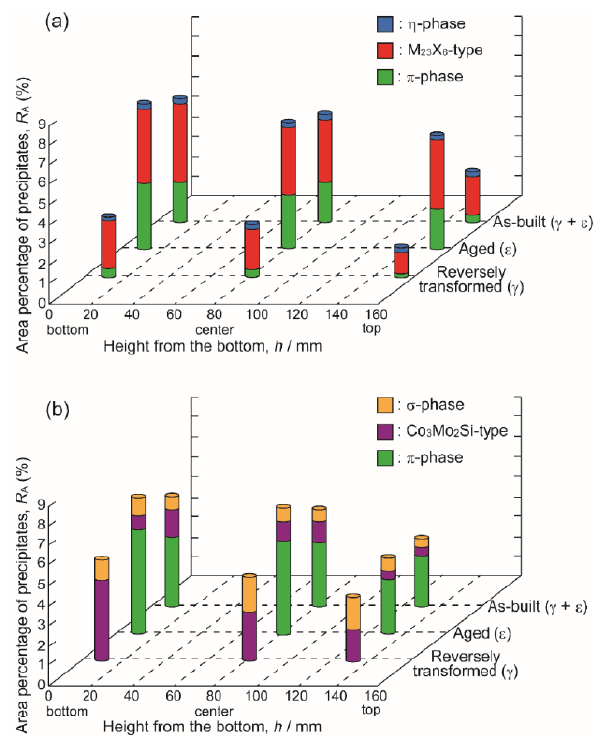
Figure 9. Areal percentages of the precipitates formed in the ( a ) high-C and ( b ) low-C alloys.